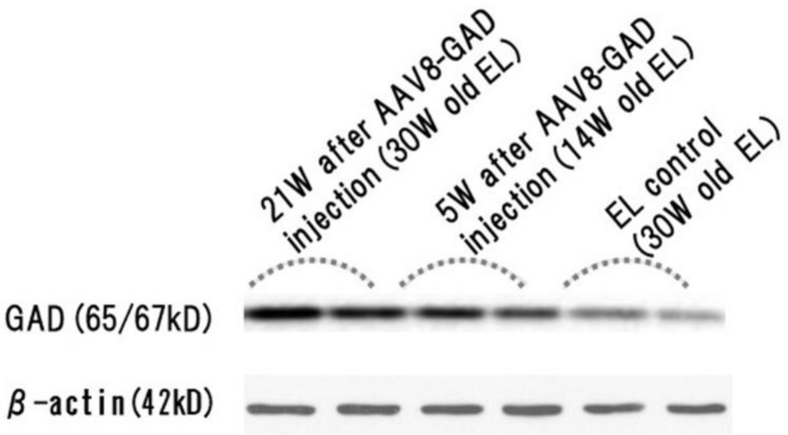
Western Blot Analysis of GAD65/67 Expression in the Hippocampi of Naive and Treated EL MiceGAD65/67 expression levels in the EL hippocampus were examined by western blotting. GAD65/67 expression was upregulated in the hippocampi of rAAV8-GAD67-treated mice. Actin served as a loading control.